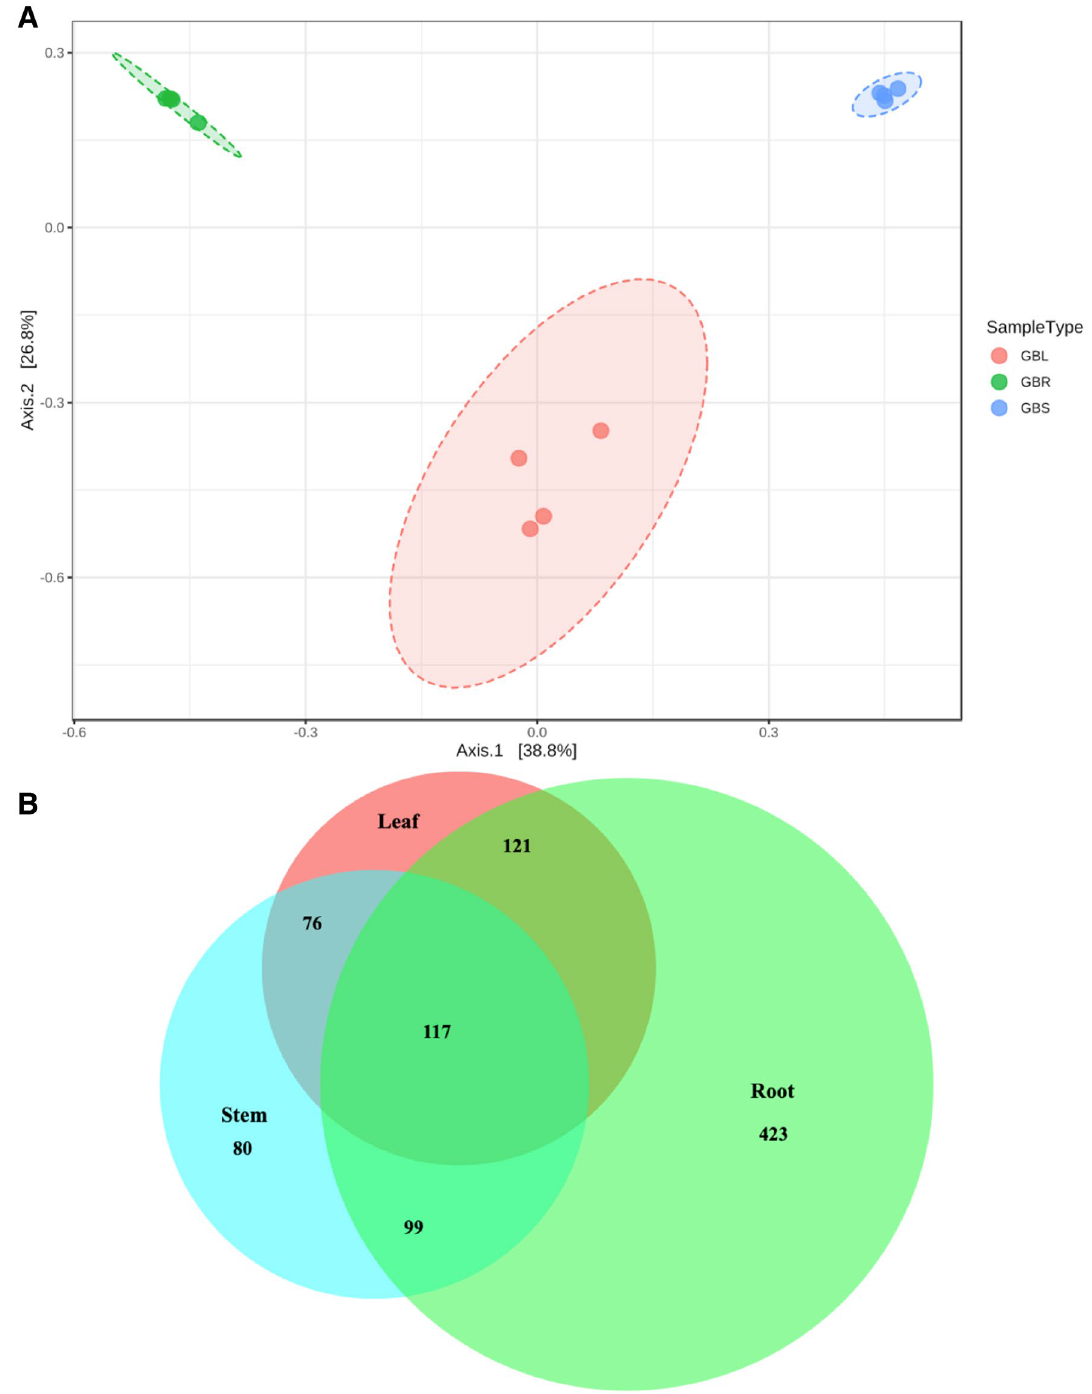
Figure 3. Beta diversity in Ginkgo biloba tissues ( A ) Principle coordinates analysis (PCoA) based on Bray–Curtis Index ( B ) Venn diagram demonstrating the proportions of unique and overlapping operational taxonomic units (OTUs) between the different tissues. Venn diagrams were created using BioVenn online tool (http:// www. biove nn. nl). GBL, GBR, and GBS refer to Ginkgo biloba leaf, root and stem,